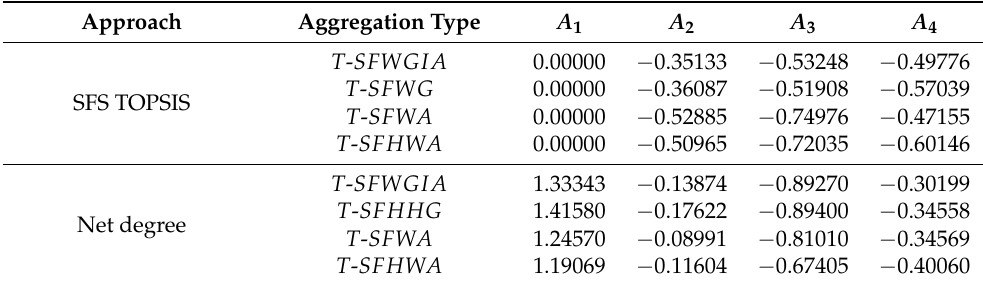
Table 2. Obtained evaluations of alternatives A 1 – A 4 for the net degree approach and SFS TOPSIS for the considered aggregation functions.